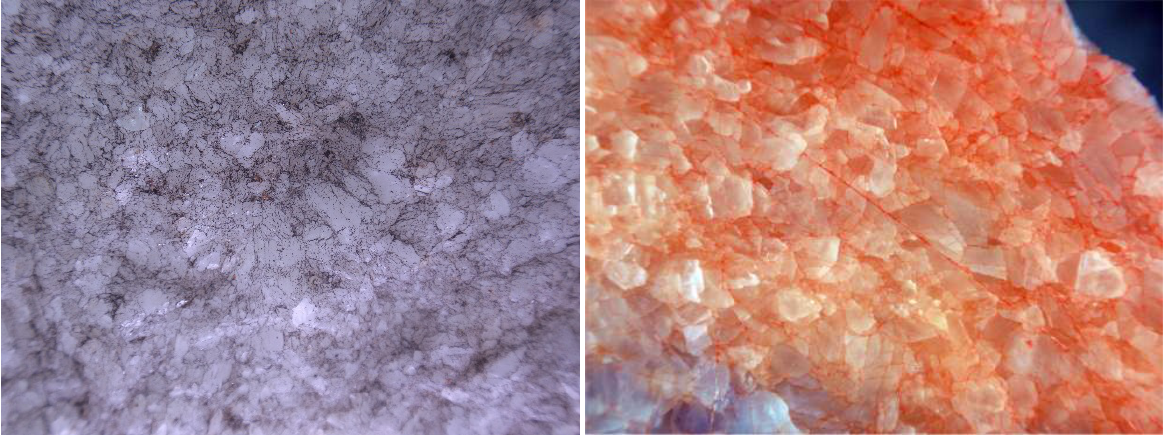
Figure 7: Close-up photographs of potential replacement marble taken in the field using a macro-tube camera. Naturally-occurring dust particles in the image on the left, and applied dye in the image on the right enhance the grain